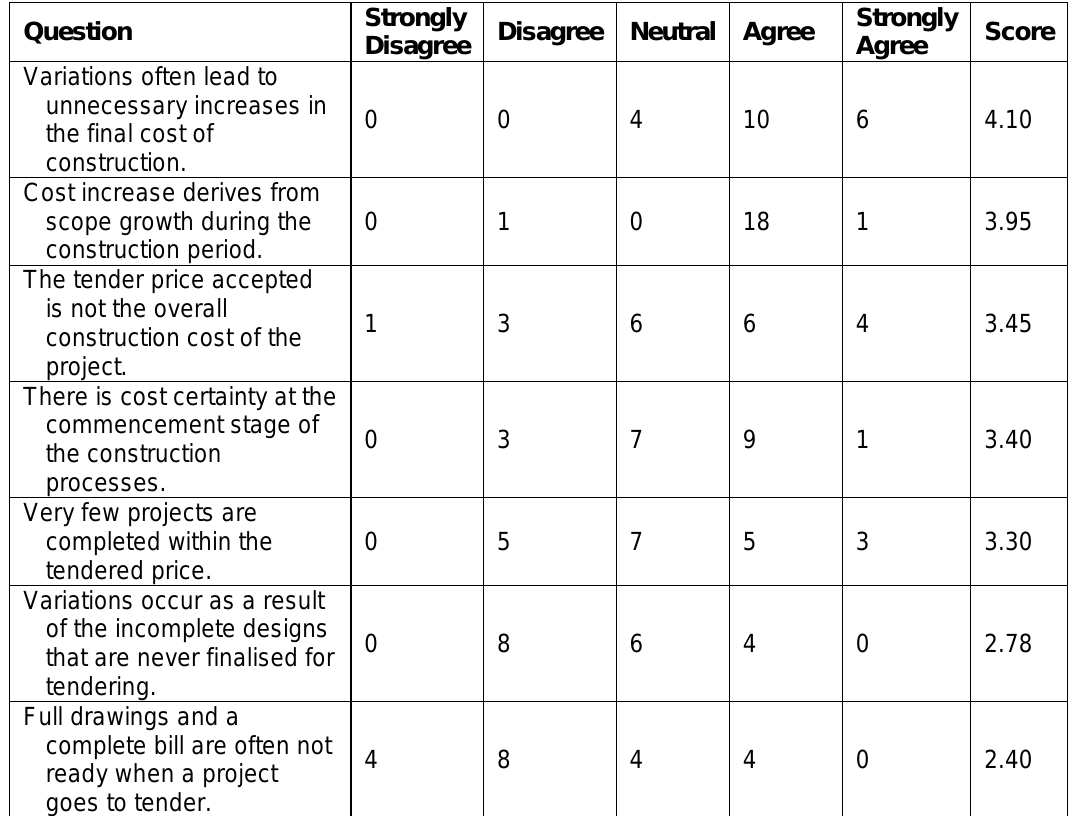
Table 2: Effects of cost